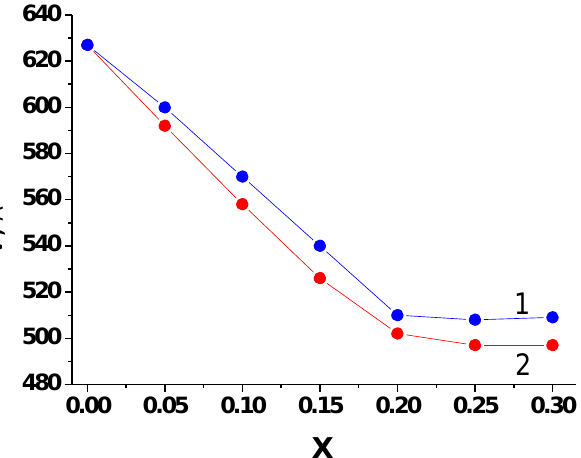
Figure 9. Concentration dependence of the volume of elementary cells in the monoclinic solid solutions of Li 6-x Zr 2-x Nb x O 7 (1) and Li 6-x Zr 2-x Ta x O 7 (2).